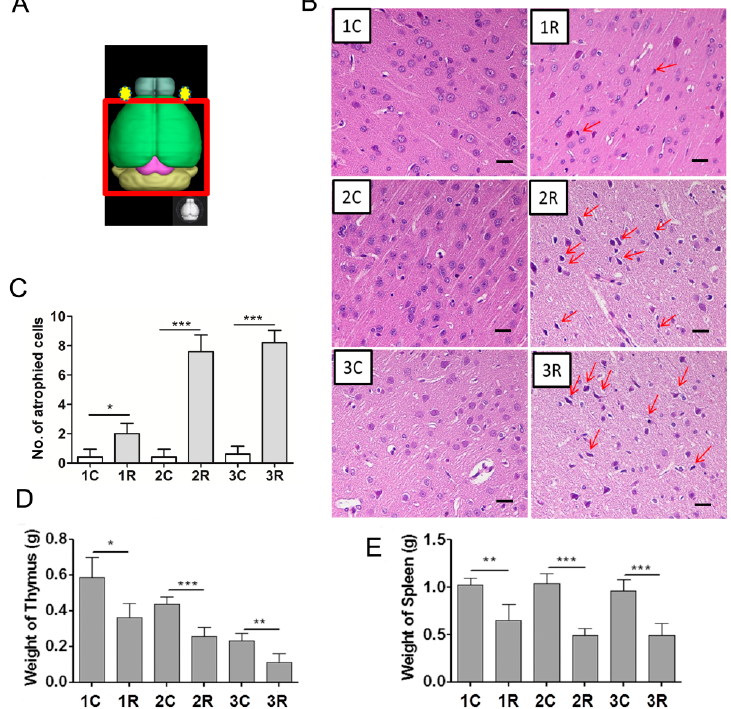
Figure 2. Brain-localized carbon ion radiation induces neural tissue injury and reduces the weight of the thymus and spleen. ( A ) Diagram of brain-localized radiation with carbon ions; ( B ) Hematoxylin and eosin staining of the parietal lobe cortex. Representative photographs from three rats are shown. The red arrows indicate specialized cells (bar = 20 μ M); ( C ) Quantitative analysis of the specialized cells in the parietal lobe cortex; ( D ) Weight of the thymus at the indicated time points; ( E ) Weight of the spleen at the indicated time points. 1C, 2C, and 3C: control rats, one, two, and three months after mock irradiation, respectively. 1R, 2R, and 3R: irradiated rats, one, two, and three months after irradiation, respectively. * p < 0.05, ** p < 0.01, *** p < 0.001.